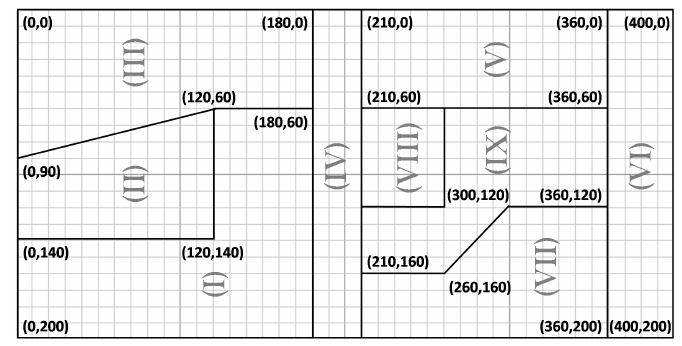
Figure 6. Splitting of the farmland.